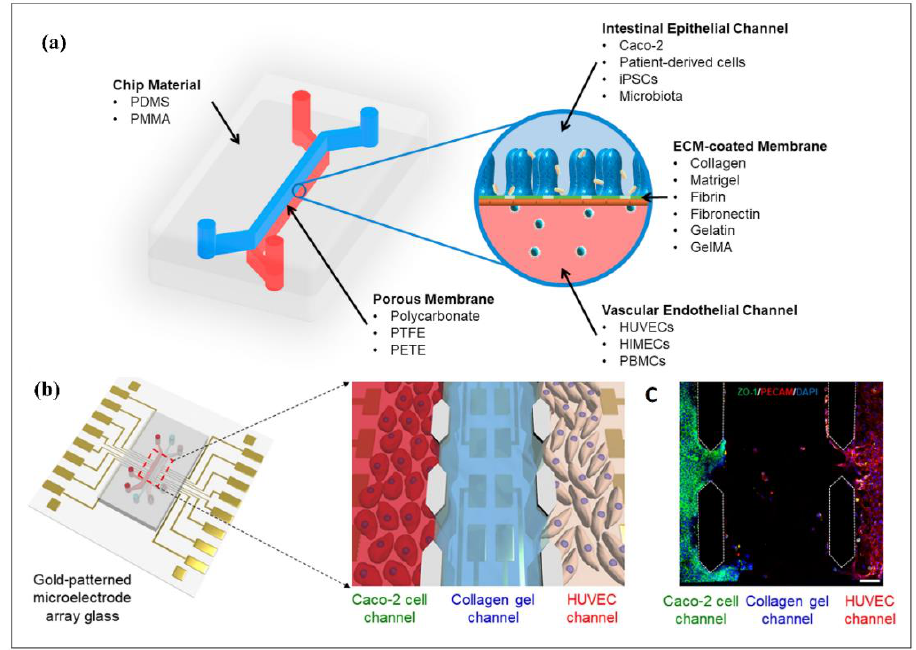
Figure 12. ( a ) A representative model and components of gut-on-a-chip platform. Reprinted with permission from ref. [373], Copyright 2020, Elsevier. ( b ) The human gut-on-a-chip platform was presented by Jeon et al. to reproduce gastrointestinal structure with co-culture of human and mi- crobial cells. The human Caco-2 cells were utilized to form intestinal lumen, whereas HUVECs were employed to establish vascular lumen in right and left channels, respectively. The channels were separated by collagen type I gels, and the continuous flow of medium was enhanced by osmotic pump. (c) Immunofluorescence staining results indicated that PECAM-1-positive HUVECs and ZO- 1-positive Caco-2 cells were positioned in the left and right channels. Reprinted from ref. [377] (open